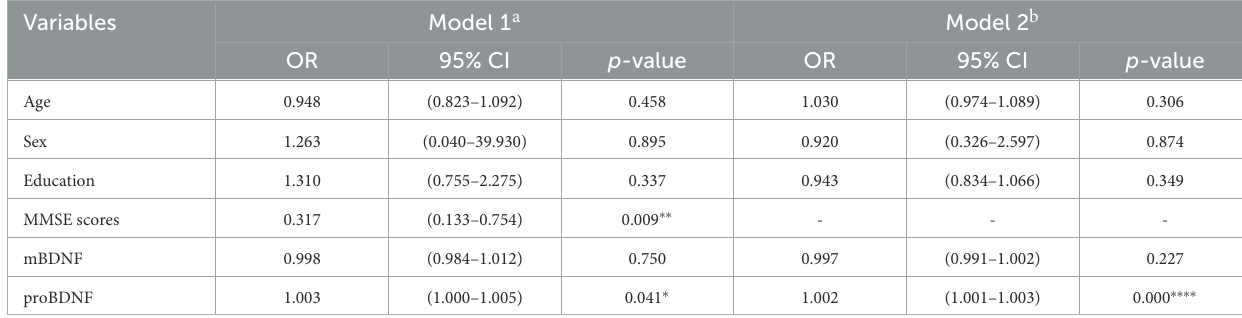
TABLE 3 Odds ratios of AD according to different features in all subjects.